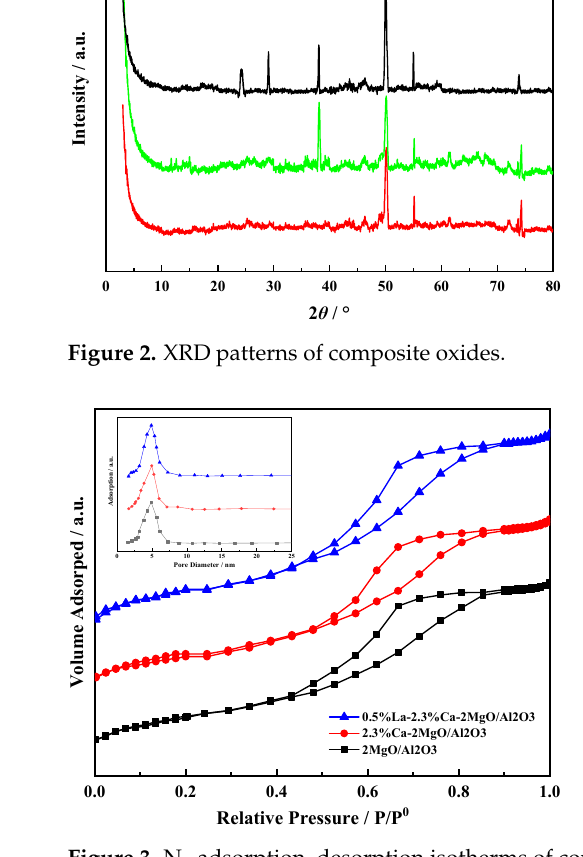
Figure 3. N 2 adsorption–desorption isotherms of composite oxides. Table 2. Structural properties of composite